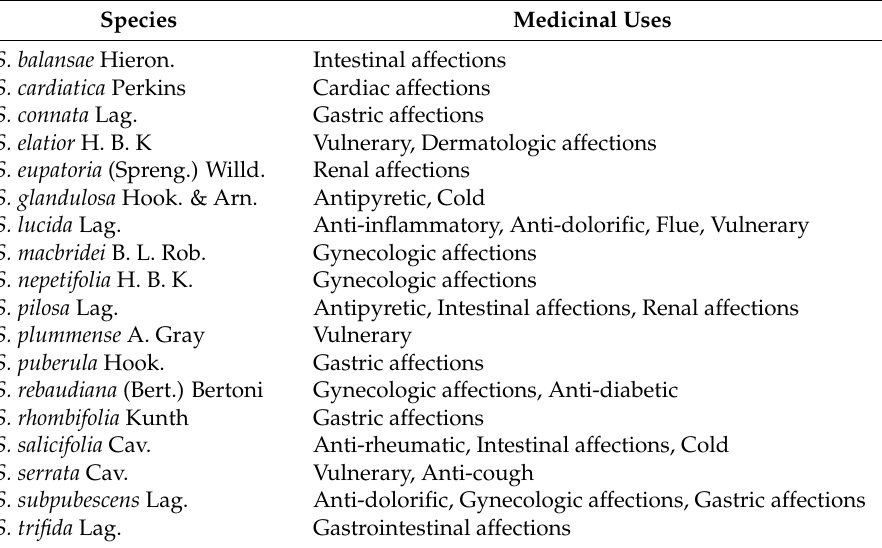
Table 2. Medicinal uses of Stevia species [48,49].